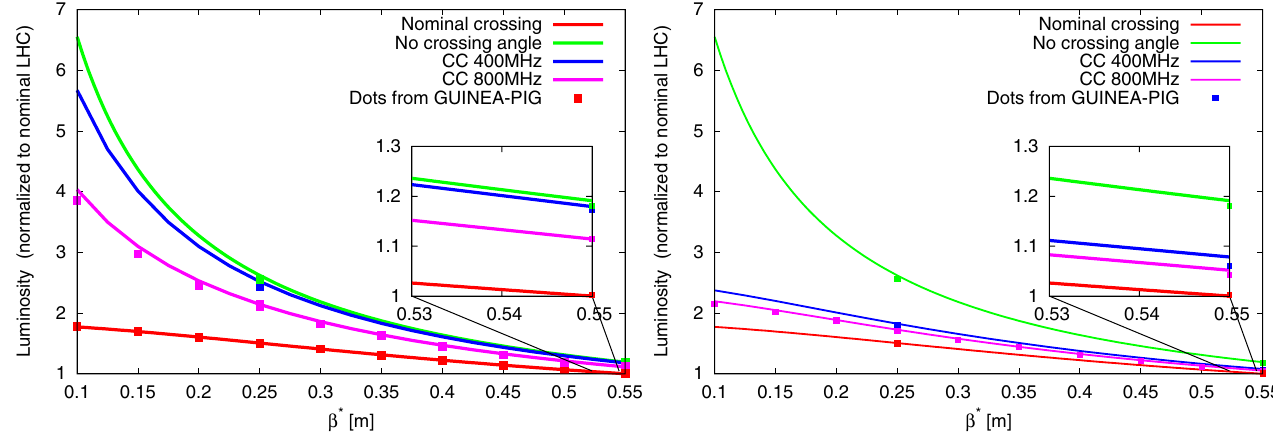
FIG. 14. (Color) Comparison of normalized luminosity between analytical formulas (curves) and GUINEA-PIG simulations (dots), with two horizontally crabbed beams (each by a crabbing angle of (cid:2)= 2 ) at IP5 (left); and with only one horizontally crabbed beam (by a crabbing angle of (cid:2)= 2 ) at IP5 (right). Simulations and analytical expressions